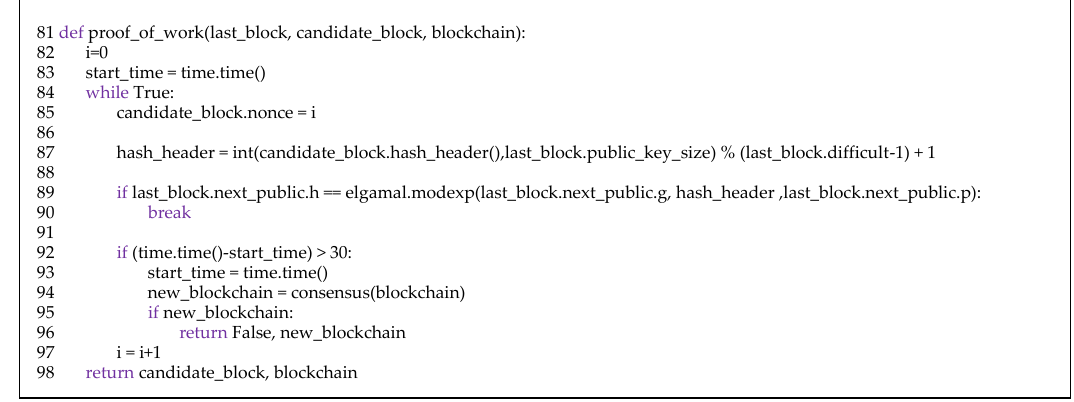
Figure 11. Implementation of proof-of-work.